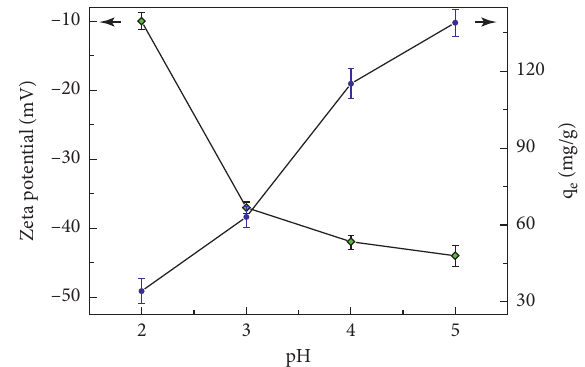
Figure 5: Zeta potential of PAC850-1-3 and the effect of pH on the adsorption capacity of Cu(II) (PACs dose: 0.0500g; temperature: 30 ° C; pH: 2, 3, 4, 5; concentration of Cu(II): 100mg/l). Error bars indicated standard deviation of three replicated experiments.